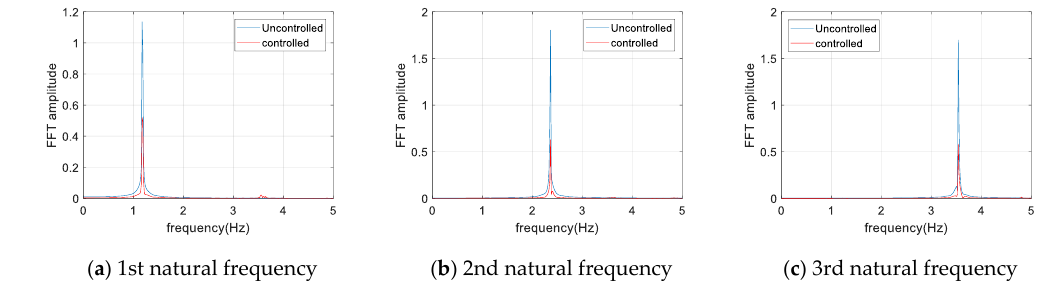
Figure 12. FFT plot for sinusoidal input. Table 6. Response decay ratio for sinusoidal input (decay ratio).